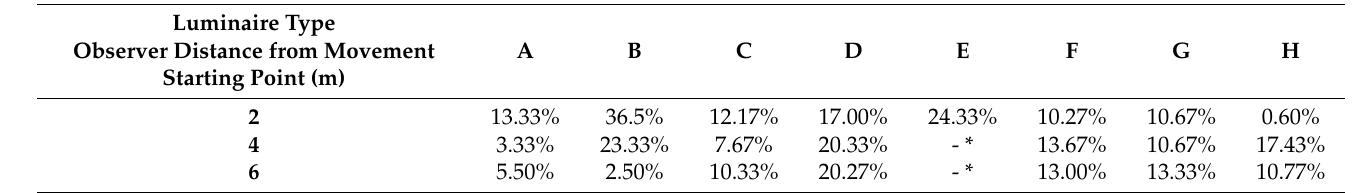
Table 7. The deviation of 2D-interpolated or extrapolated UGR table data from the simulated UGR as a percentage of 30 units of UGR for luminaires A to H. Difference between Proposed Method and Simulation Results as a Percentage of 30 Units of